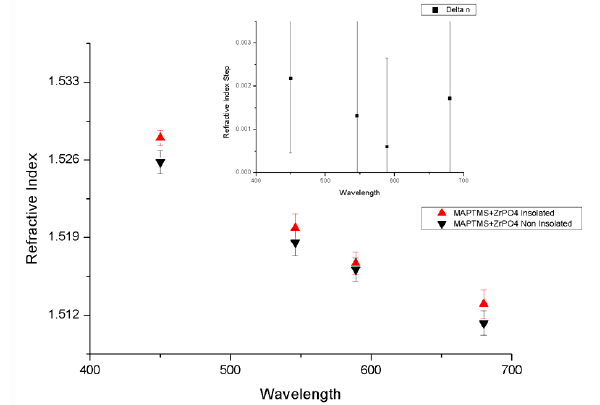
Figure 1: Refractive Index of cured and non cured MAPTMS (annealed at 110 degrees Celsius) and refractive index step